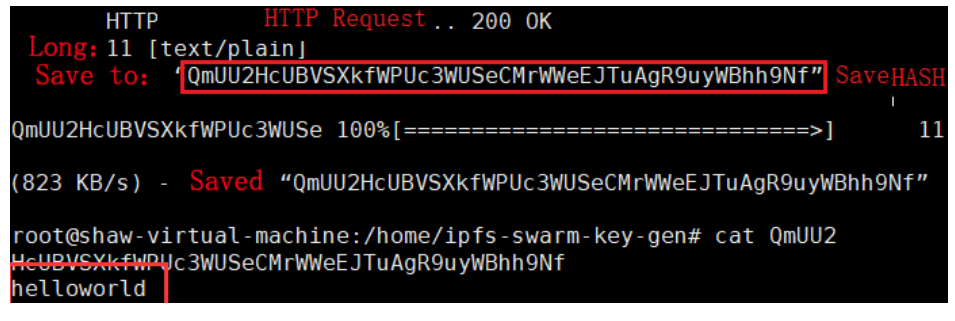
Figure 11. File download on the master node.